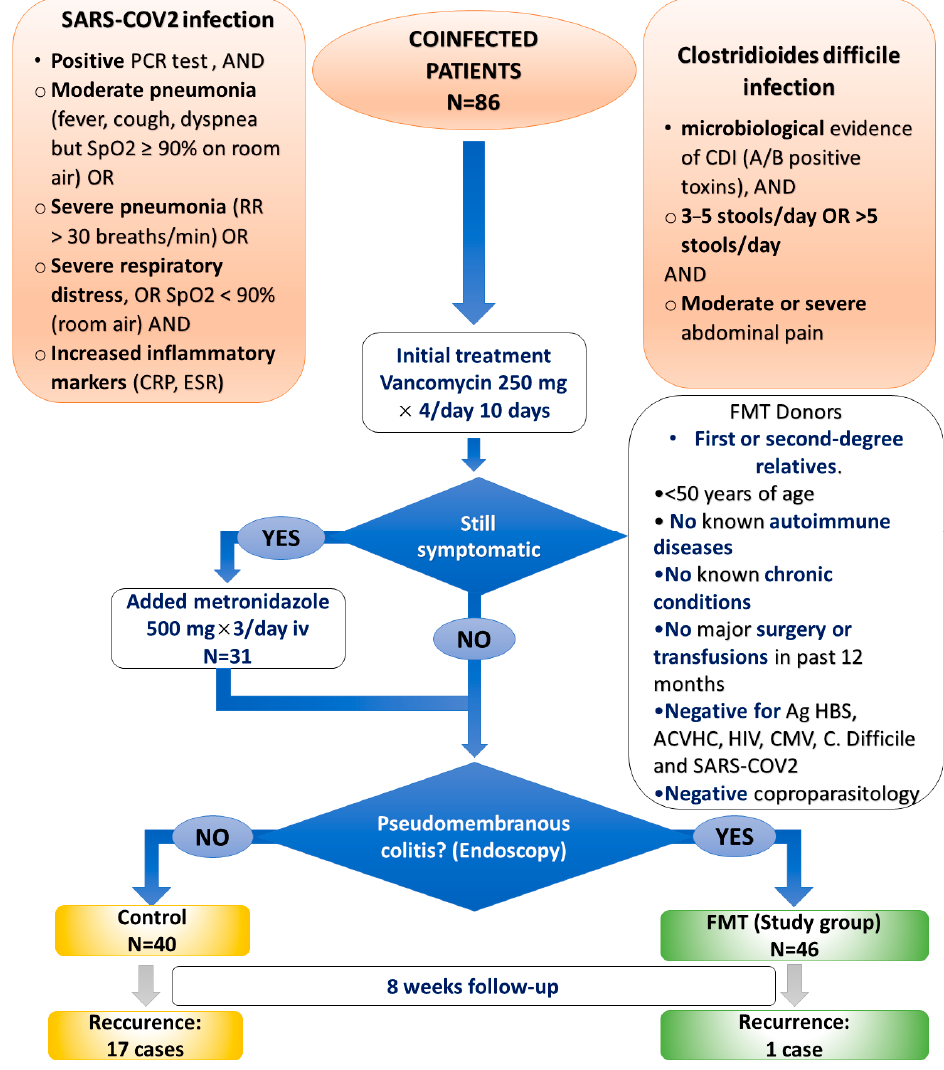
Figure 3. Study design and results regarding disease recurrence.